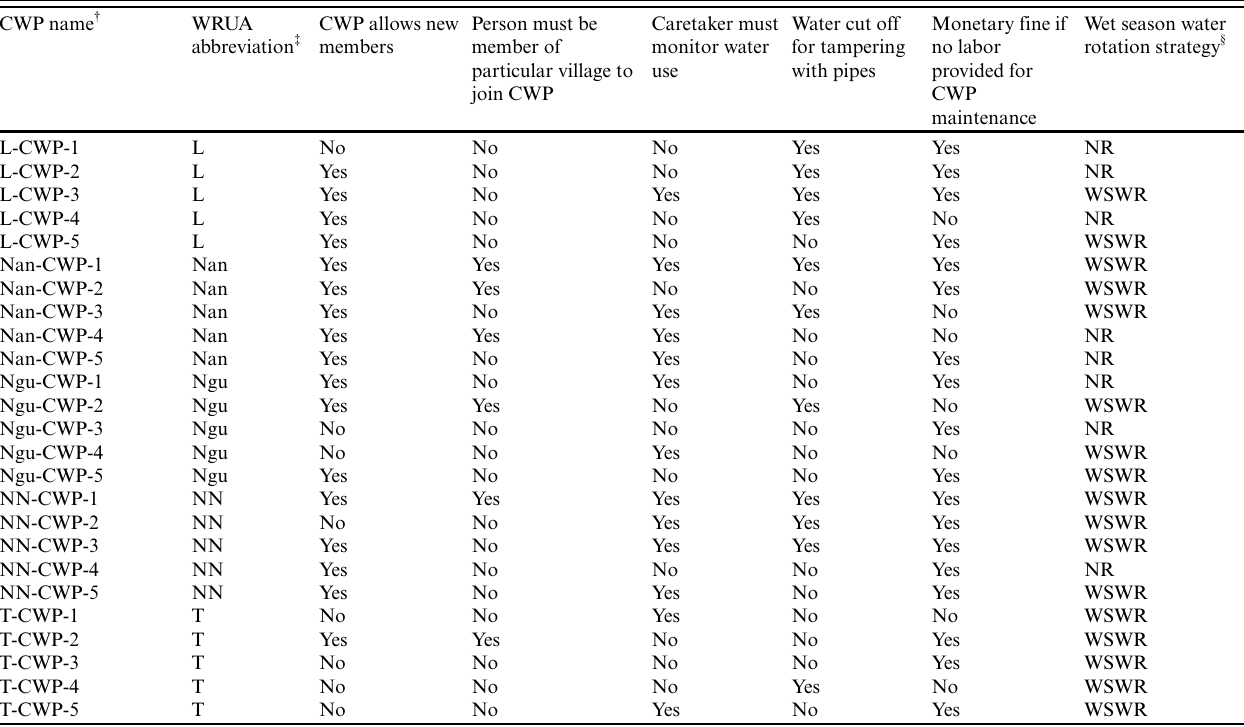
Table 2. Select institutional infrastructure attributes of CWPs CWP name † WRUA